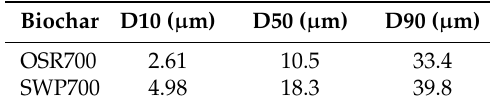
Table 2. Cumulative particle size distribution at 10% (D10), 50% (D50), and 90% (D90) for OSR700 and SWP 700 biochars.